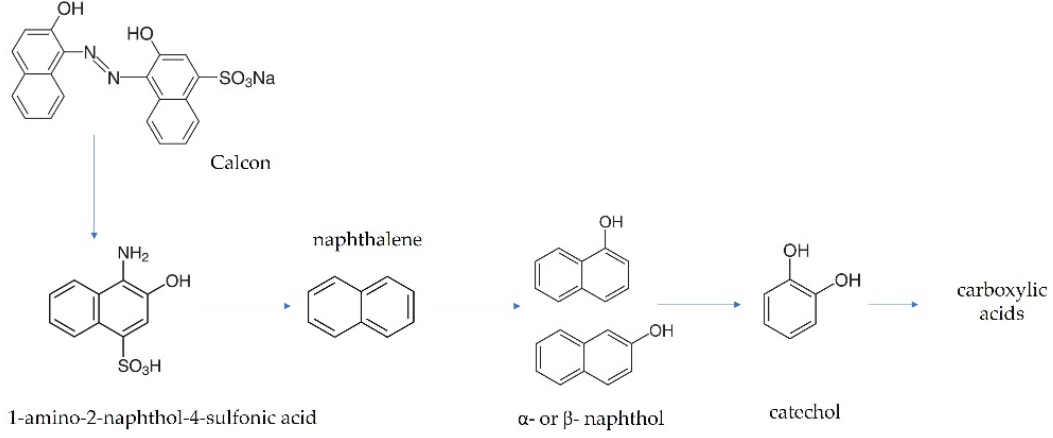
Figure 9. Proposed pathway for the EO of Calcon at BDD anodes in 0.25 M H 2 SO 4 .